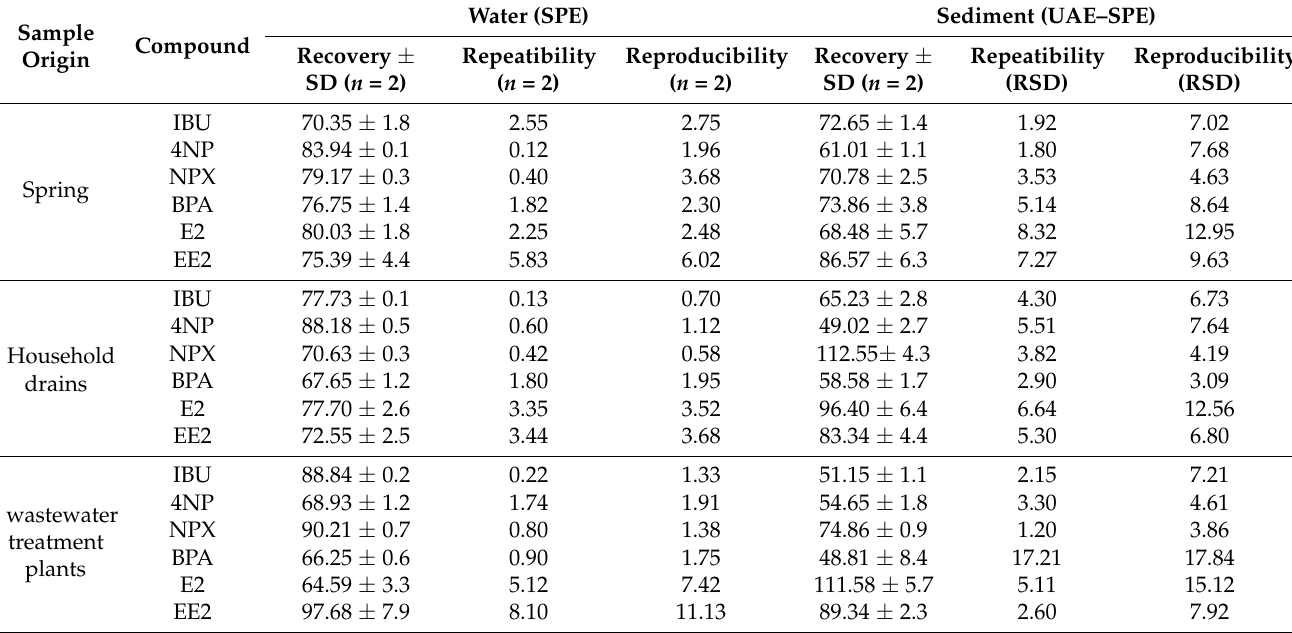
Table 3. Validation of extraction methods for water and sediment samples.